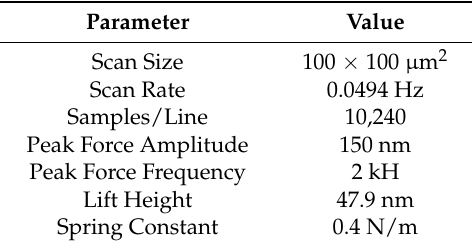
Table 4. AFM detection